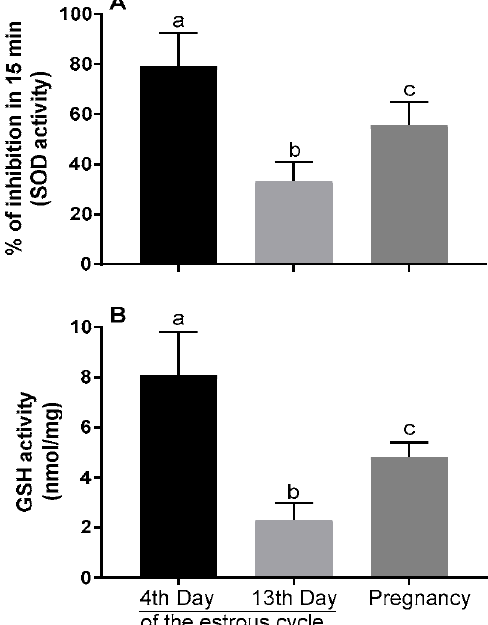
Figure 4. Activity of superoxide dismutase (SOD) and reduced glutathione (GSH) in red deer blastocysts developed from the oocytes collected on the 4th day versus the 13th day of the estrous cycle versus during pregnancy, as determined colorimetrically. Bars represent percentage (A) and (B) mean ± SEM. Different letters (a, b, c) indicate statistically significant differences. p < 0.05 was considered statistically significant.